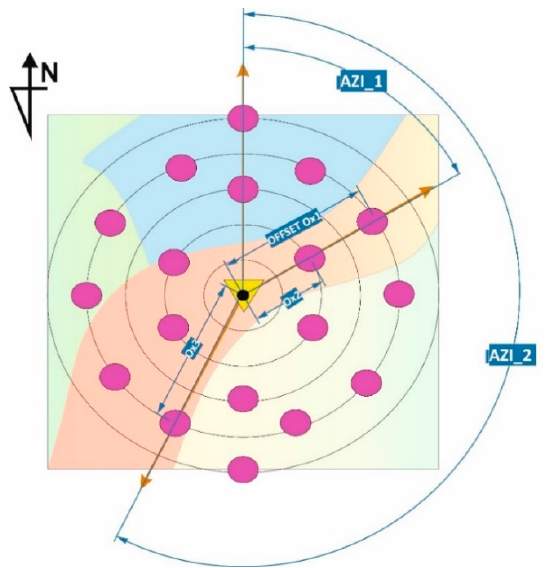
Figure 5. Delay Time Analysis method scheme: O—the distance from source to receiver in a straight line, V 1 , V 2 —the velocity of layer 1 and layer 1 with the assumption V 1 < V 2 ,  1,  2—the volumetric density of layer 1 and layer 2, RS—true ray path from source to refractor, RR true ray path from receiver to refractor, Z RS , and Z RR —vertical component of RS and RR, d S and d R —horizontal